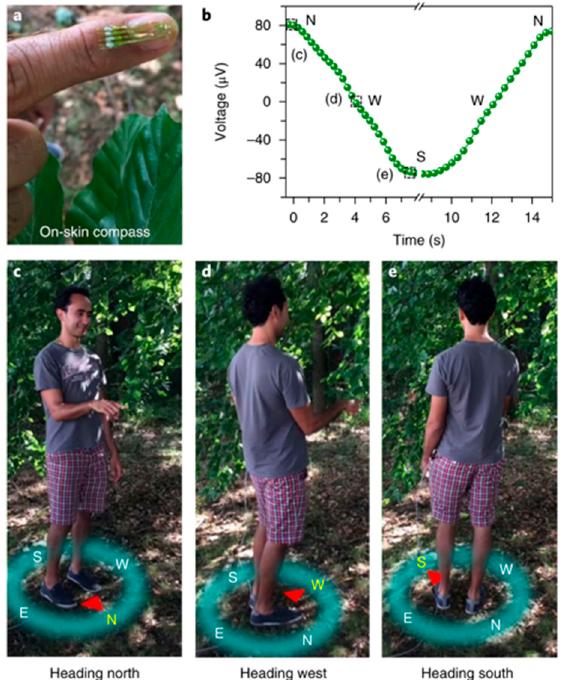
Figure 18. Outdoor geomagnetic exploration by E-skin compass. ( a ) E-skin compass attached to the finger; ( b ) Time evolution of the output voltage of the e-skin compass when the person rotates back and forth from the magnetic north (N) to magnetic south (S) via west (W); ( c – e ) Pictures of people facing N, W, and S. Adapted with permission from Ref. [31]. Copyright 2018, copyright Springer Nature Limited.